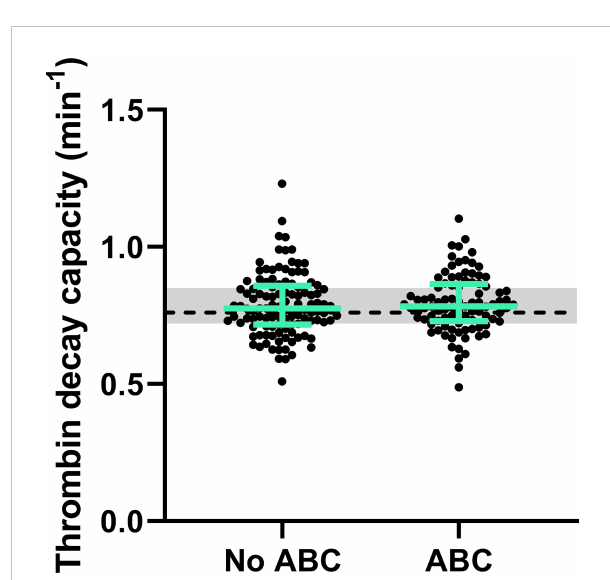
FIGURE 5 Natural anticoagulant activity in PLHIV, strati fi ed for ABC treatment. The thrombin decay capacity does not differ between PLHIV treated with ABC or another treatment regime. The data of PLHIV participants with and without ABC treatment is represented as dots with green bars indicating the group median and interquartile range. For comparison, the median of the controls without HIV is shown as a black dashed line and the interquartile range is depicted as a grey